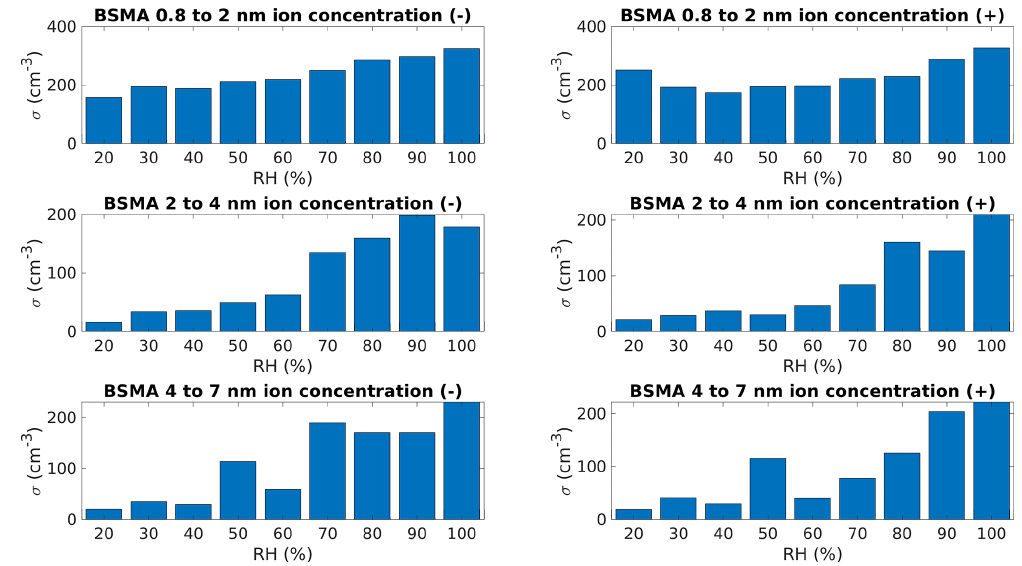
Figure A2. The standard deviation of ion concentrations measured by BSMA in different RH